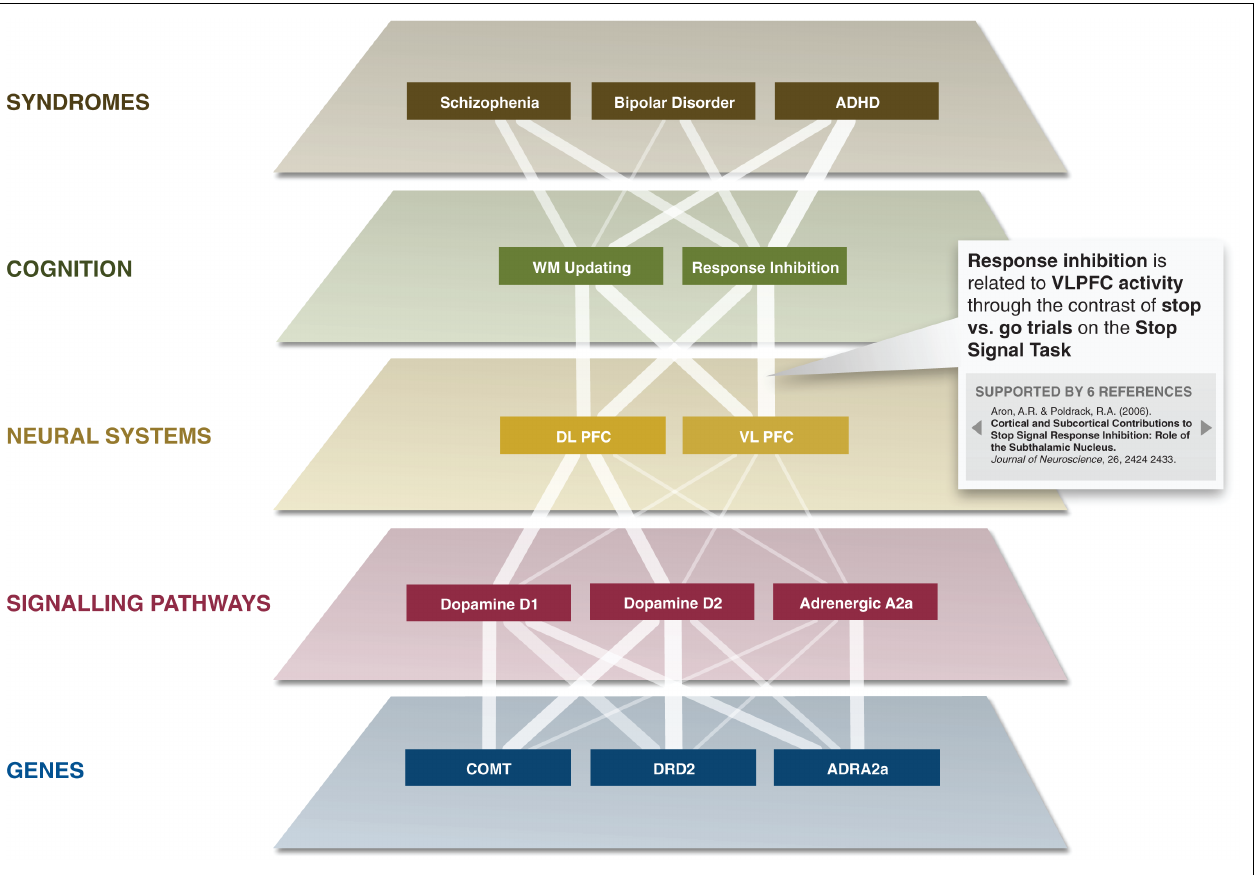
proportional to the literature association between each set of terms (defined as the Jaccard coefficient between the two search terms derived from PubMed). Each link can also be associated with specific empirical results, as noted in the box demonstrating a particular annotation for one of the